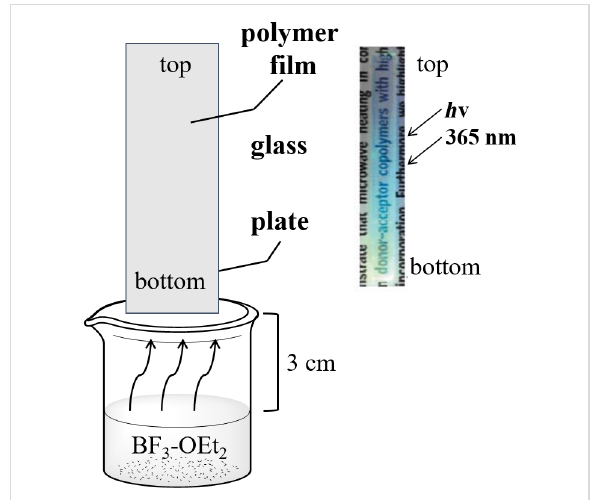
Figure 4: Schematic diagram of a BF 3 ·OEt 2 vapor-treated device and the macroscopic gradation emissive pattern of polymer films on a glass plate after treatment and excited by 365 nm UV light. Figure 4 was reproduced from [31] with permission from The Royal Society of Chemistry. This content is not subject to CC BY